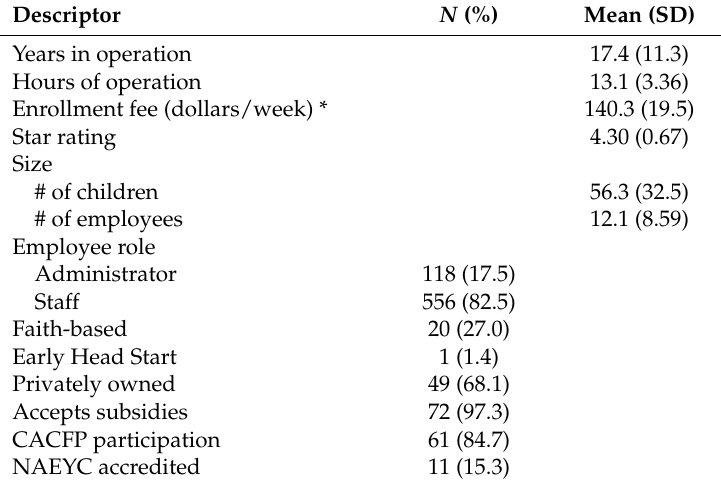
Table 2. Childcare center